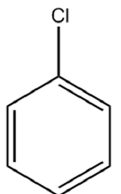
Figure 1. The framework of chlorobenzene.